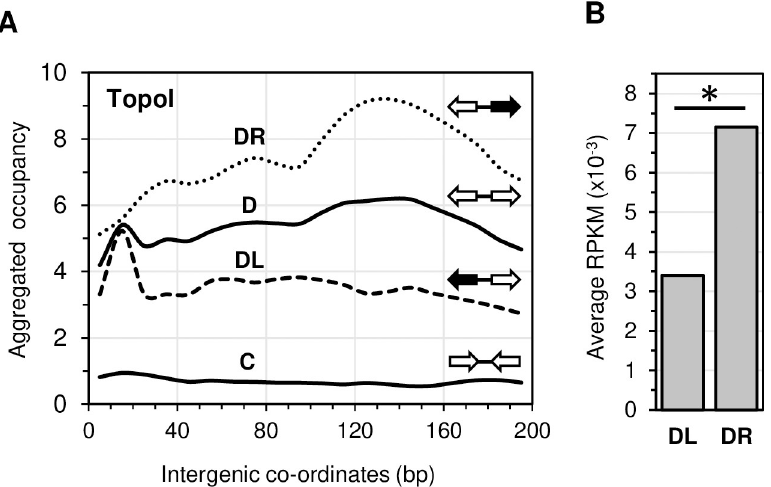
Fig 5. Differential TopoI occupancy along the intergenic regions between contiguous protein-coding genes and its relation to the expression level of the head-on gene. A) Aggregated occupancy of TopoI in the intergenic regions of divergent genes (D), convergent genes (C), divergent gene pairs located in the left replichore (DL) and divergent gene pairs located in the right replichore (DR) as indicated in Fig 4A. Head-on genes are indicated with black arrows in DL and DR. B) Average RPKM of the head-on gene of DL and DR gene pairs. Statistical significance: � P < 0.05.